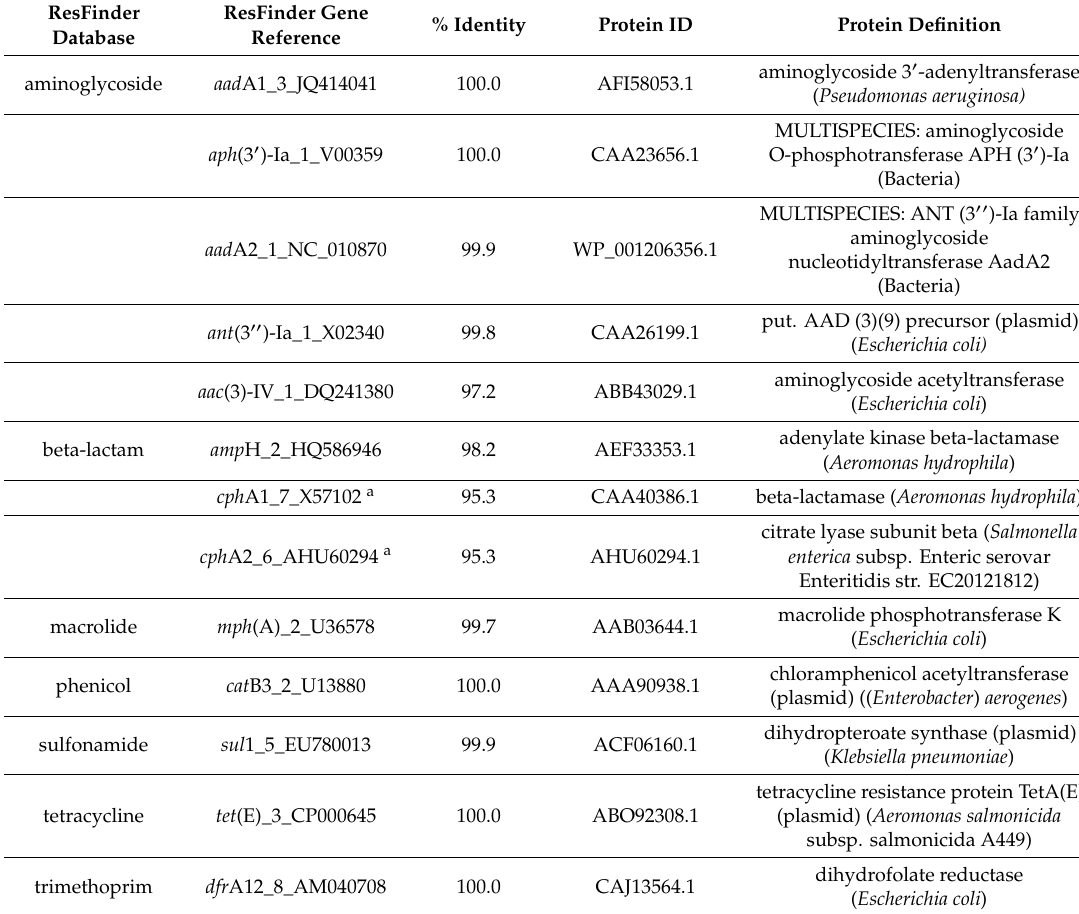
Table 2. Alignment of Aeromonas hydrophila CVM861with sequences from the ResFinder